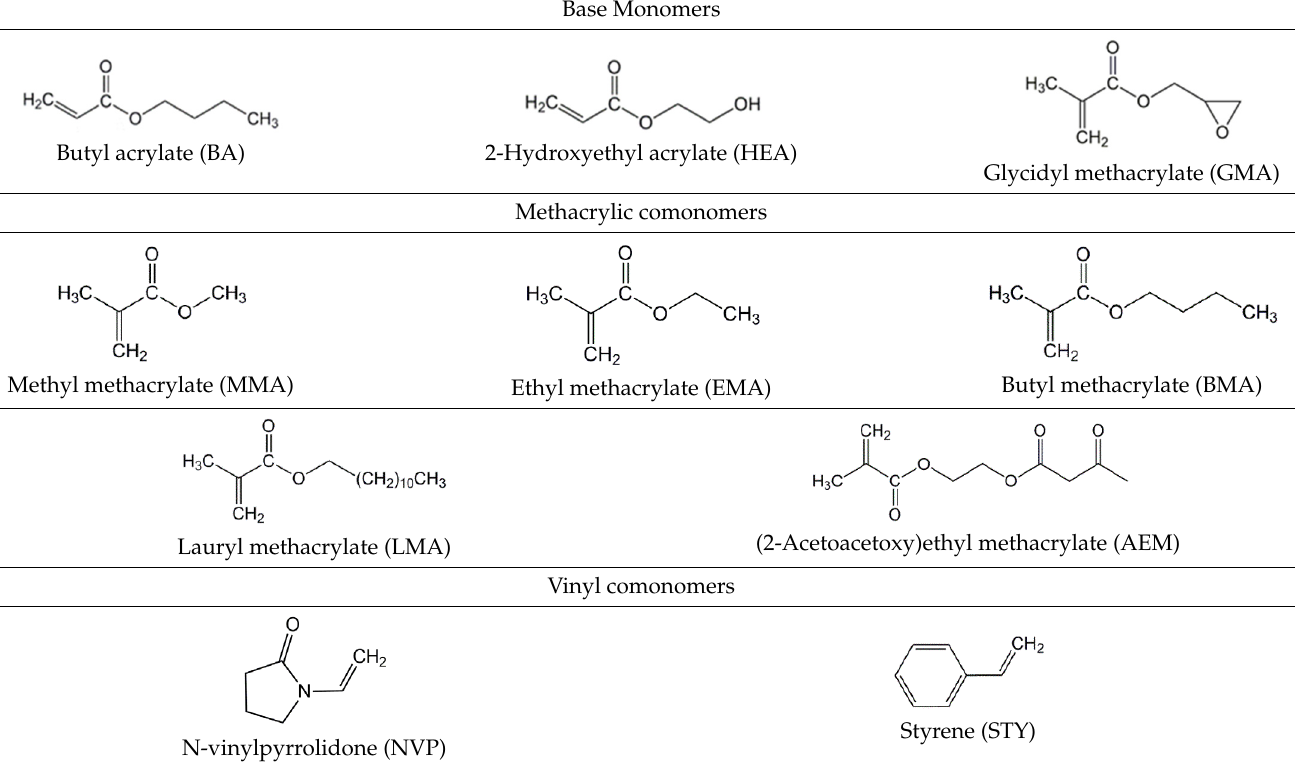
Table 1. Chemical structures of used Table 1. Chemical structures of used comonomers. Table 1. Chemical structures of used comonomers. Table 1. Chemical structures of used comonomers. Table 1. Chemical structures of used comonomers. Base Monomers Base Monomers Table 1. Chemical structures of used comonomers. Table 1. Chemical structures of used comonomers. Table 1. Chemical structures of used comonomers. Table 1. Chemical structures of used comonomers. Base Monomers Base Monomers